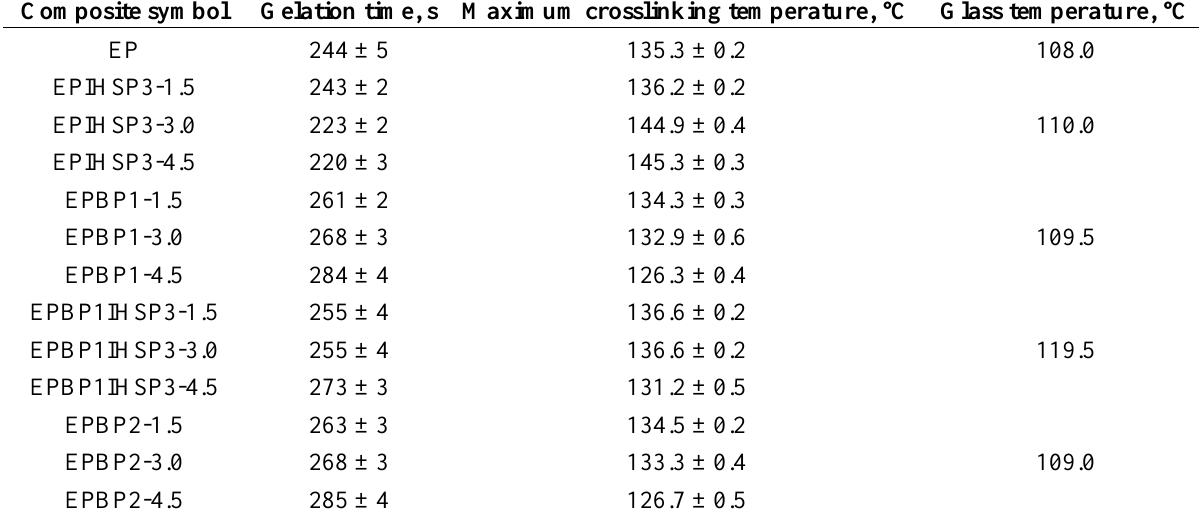
Table 5. Results for gelation parameters (±standard